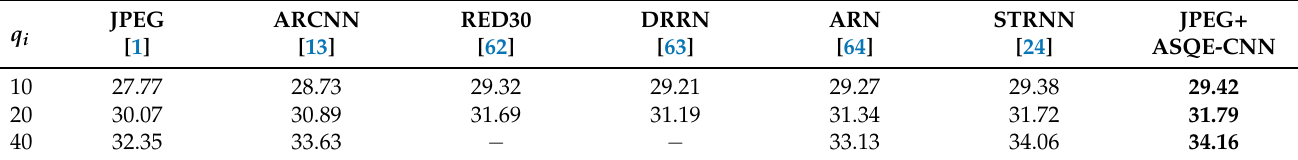
Table 4. Average PSNR (dB) results over LIVE1 [54] for grayscale